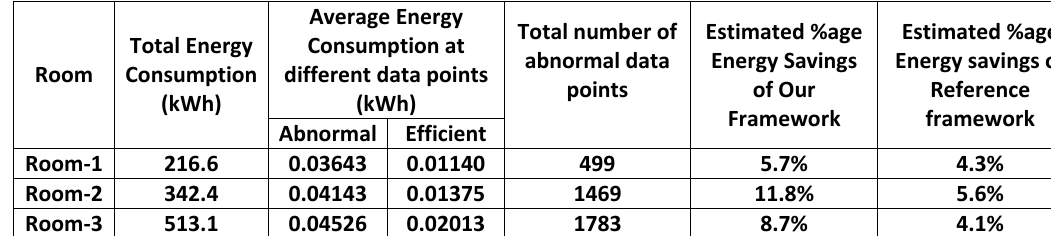
Table 1. Energy Saving Comparison of our proposed framework with a reference scheme proposed in